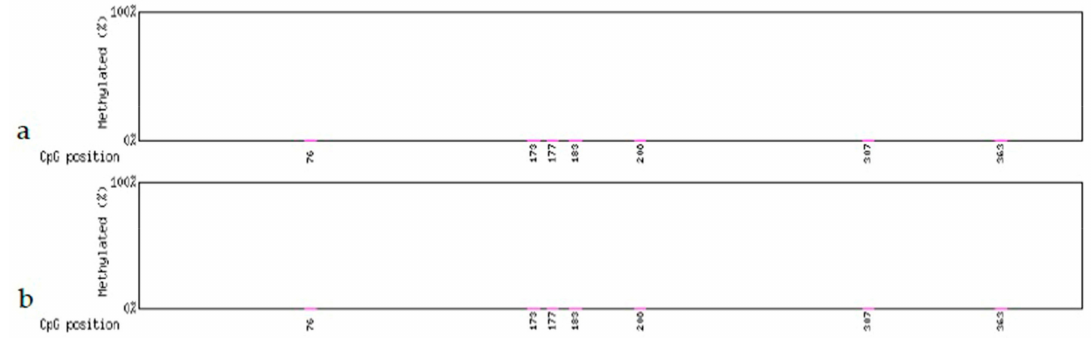
Figure 5. Methylation levels in the Gmhsp17.6-L promoter after heat-shock treatment. ( a ) Non-deletion transgenic line 98-3-2. ( b ) Partial-deletion transgenic line